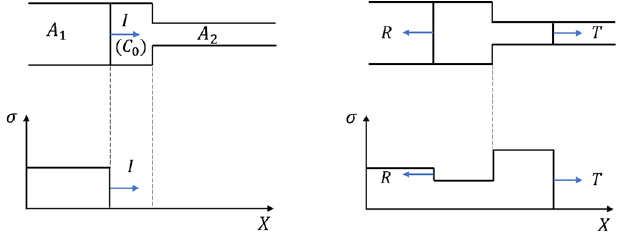
Figure 4: Reflection and transmission of stress waves in a bar with different cross